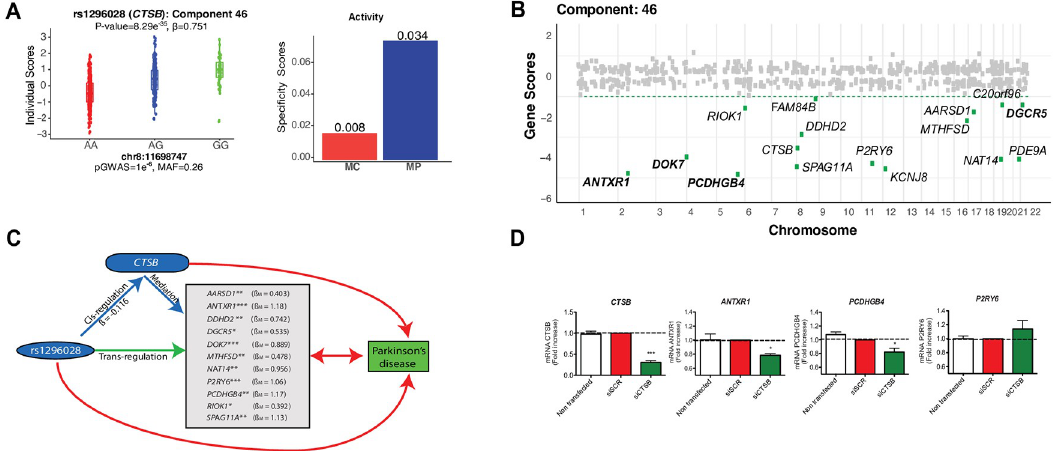
Fig 4. Macrophage-specific trans -eQTL colocalized in Parkinson’s disease associated CTSB locus. (A) The genotype for Parkinson’s disease susceptibility allele rs1296028 is significantly associated with the individual scores of CG component 46. The rs1296028 affects the expression of 16 genes in component 46 in macrophage (CG) (left panel). Tissue specificity scores suggest CG component 46 is active in macrophage (Right). P-value: ��� : < 1e-50 | �� : < 1e-10 | � : < 1e-5. (B) Gene scores for component 46 across the genome. Only the trans -eGenes with PIP > 0.5 and 2.5% distributional cut-off (green dotted line) are shown. Trans -eQTL associations that replicated (FDR < 0.20) in an independent STARNET macrophage dataset are shown in bold (C) Parkinson’s disease SNP rs1296028 mediates trans-effects to 11 genes through cis-mediator cathepsin B ( CTSB ). The beta coefficients from Mendelian randomization analysis are shown for the significant trans -eGenes. (D) Experimental validation using THP-1 derived macrophages. CTSB was knocked-down using siRNA during 48 h and the levels of the top-scoring genes in the component were measured by qPCR. Data was normalized against scramble siRNA (SCR). P-value: � : < 0.05 | ��� : < 0.001.